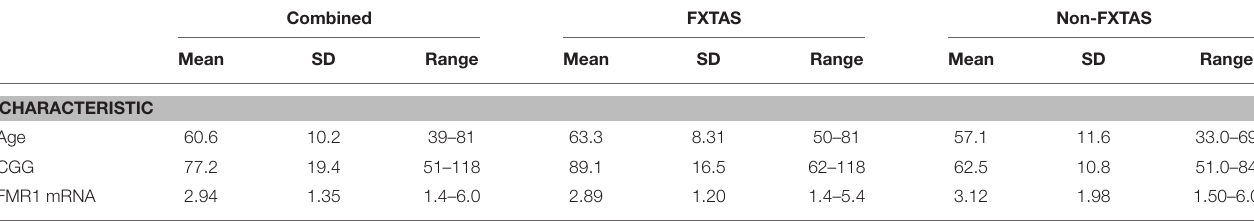
TABLE 1 | Descriptive statistics for sample characteristics for the total sample of PM carriers and separately for FXTAS and non-FXTAS groups. Combined